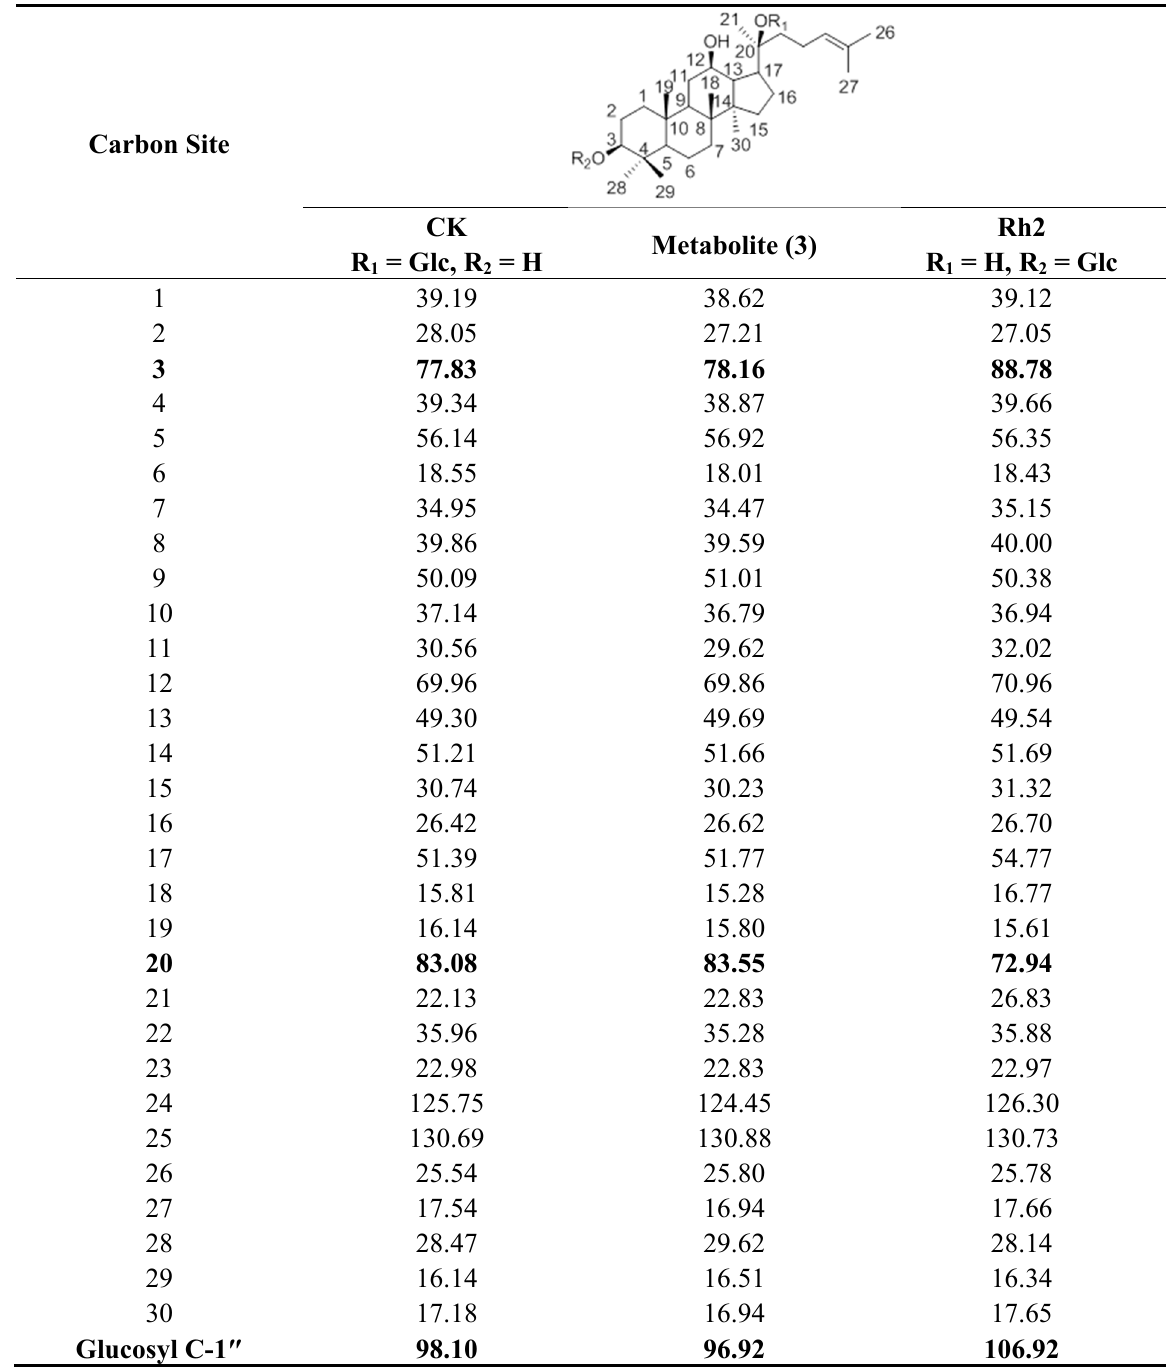
Table 4. 13 C-NMR chemical shifts of metabolite (3) in comparison with ginsenoside Rh2 and